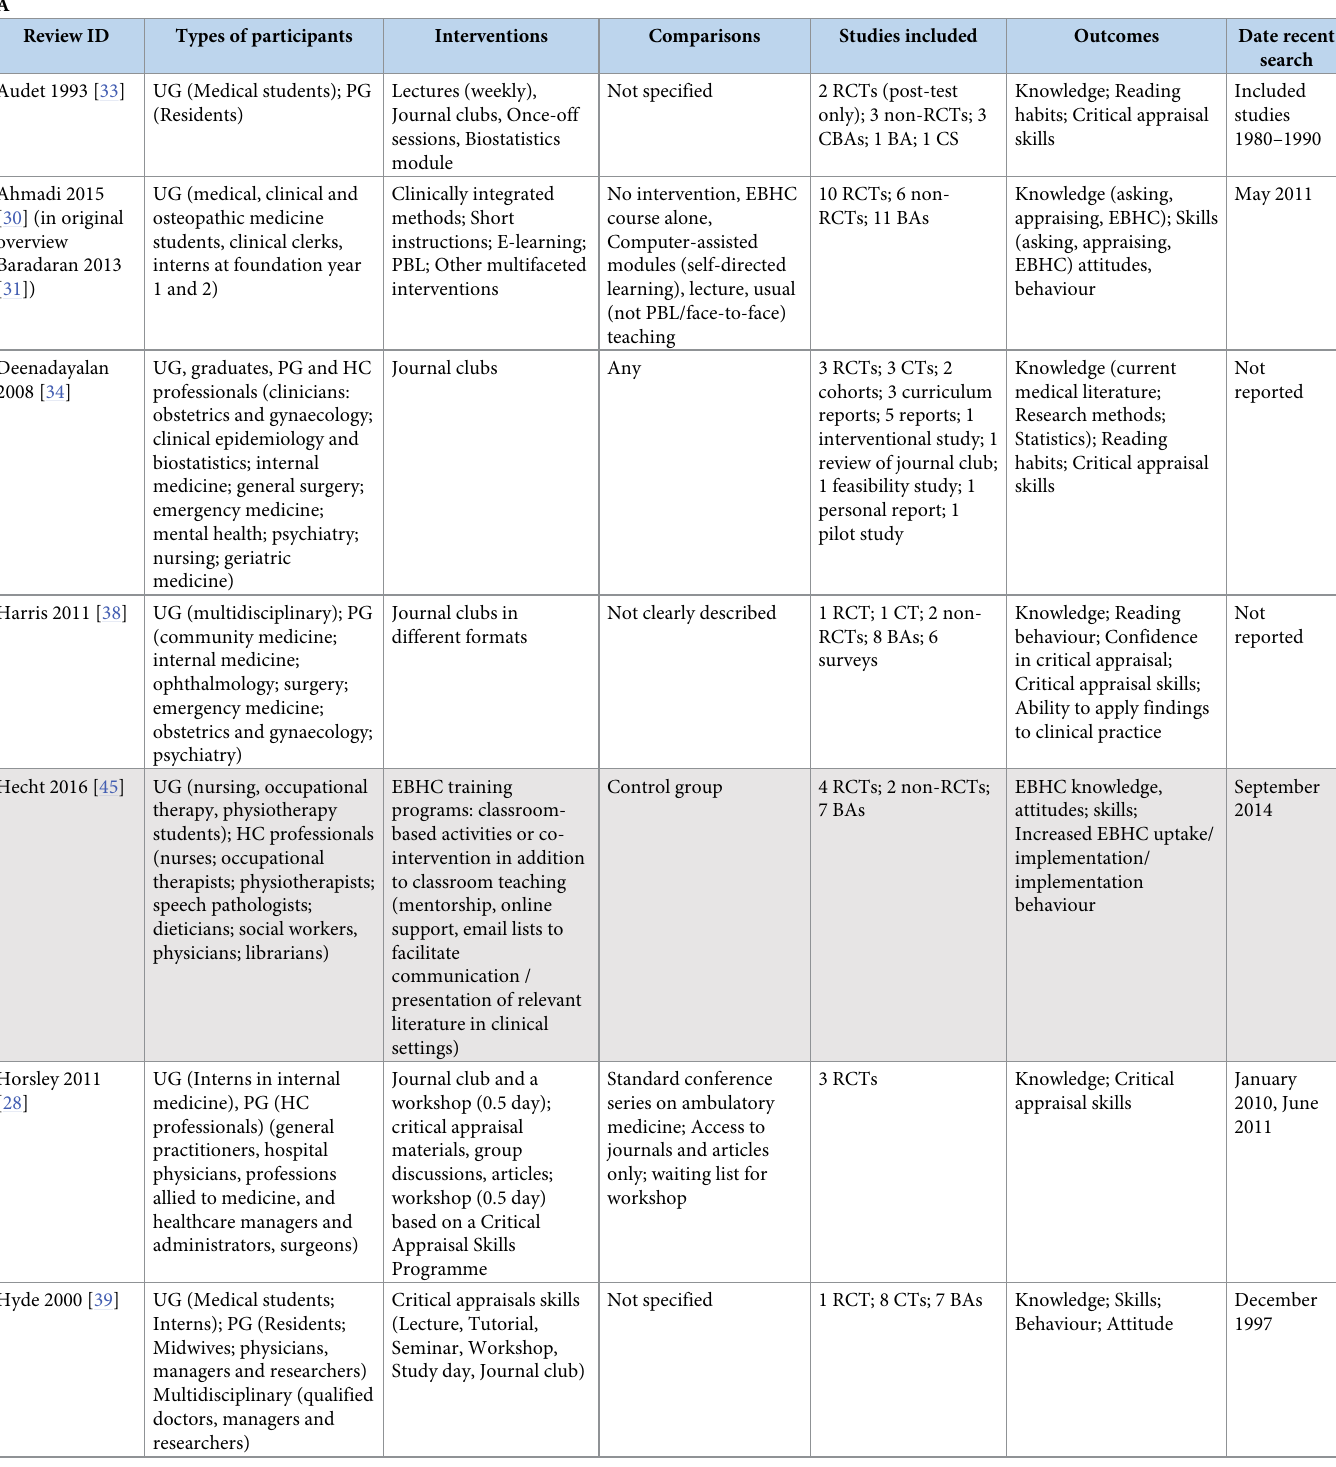
Table 2. A. Characteristics of included systematic reviews: Undergraduate (UG) and postgraduate (PG), reviews shaded in grey were newly identified. B. Characteristics of included systematic reviews: Postgraduate (PG) and continuing professional development in healthcare professionals (HCPs). Studies shaded in grey were newly